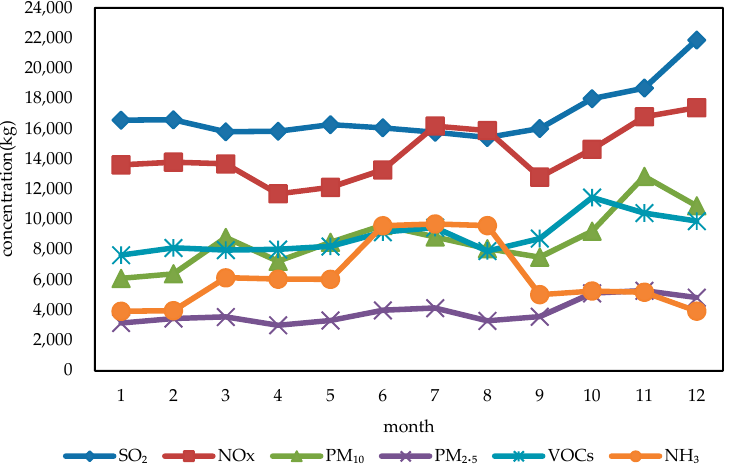
Figure 4. The emission contributions of ten source categories in the Changzhutan urban agglomeration. The monthly changes in emissions of major air pollutants in the CZT urban agglomeration.